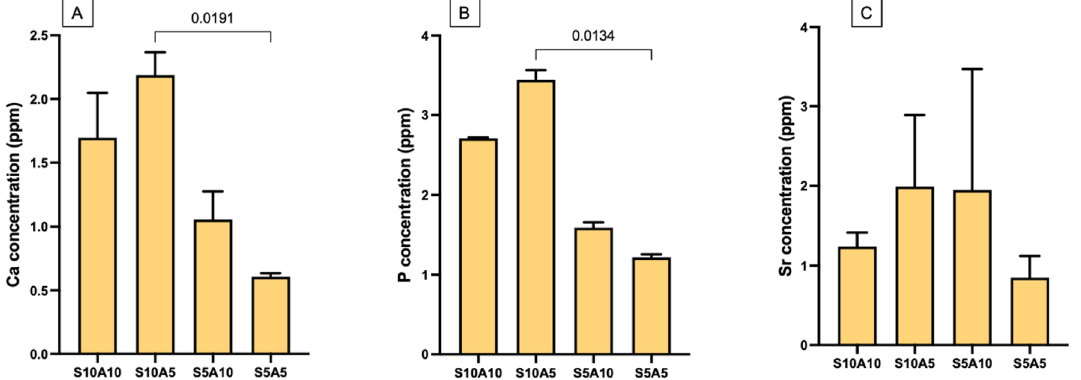
Figure 5. Concentrations of ( A ) calcium, ( B ) phosphorus, and ( C ) strontium ions contained in the storage solution at 4 weeks (mean ± SD, n = 3). The amounts of released ions from S0A0 and Trans were under the detection limit. Lines indicate p < 0.05.